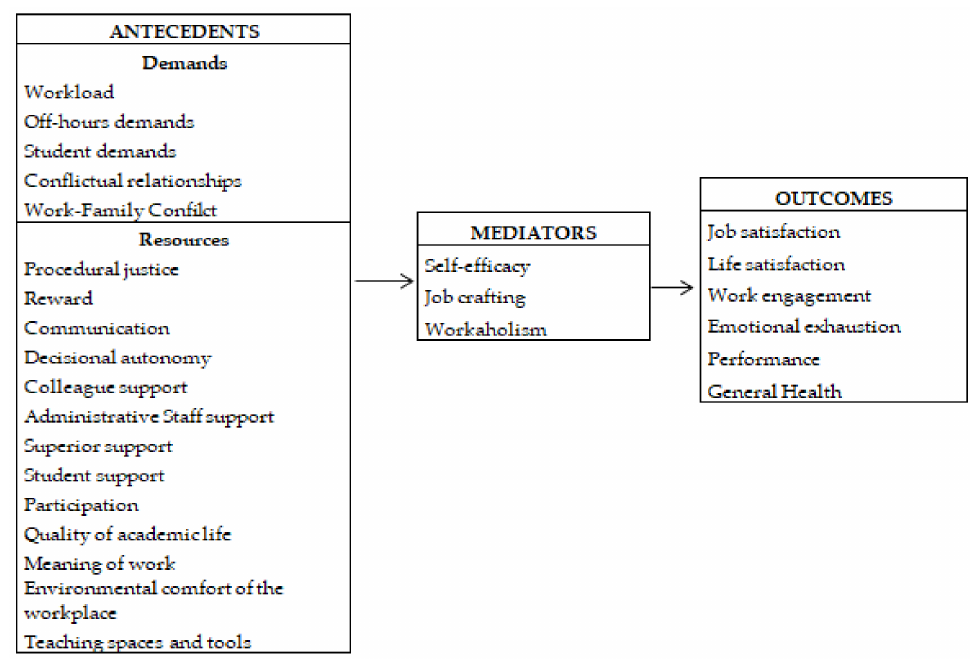
Figure 1. Set of variables composed of demands, resources, mediators, and outcomes included in Study